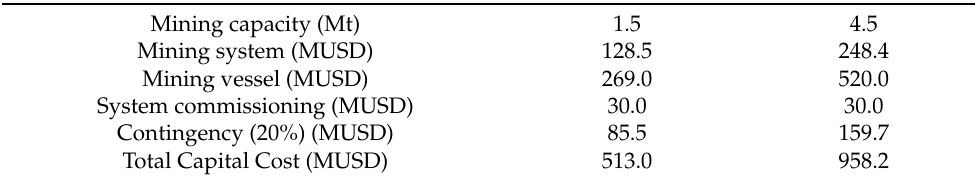
Table 4. Capital expenditures for the two extraction scales of raw ore.